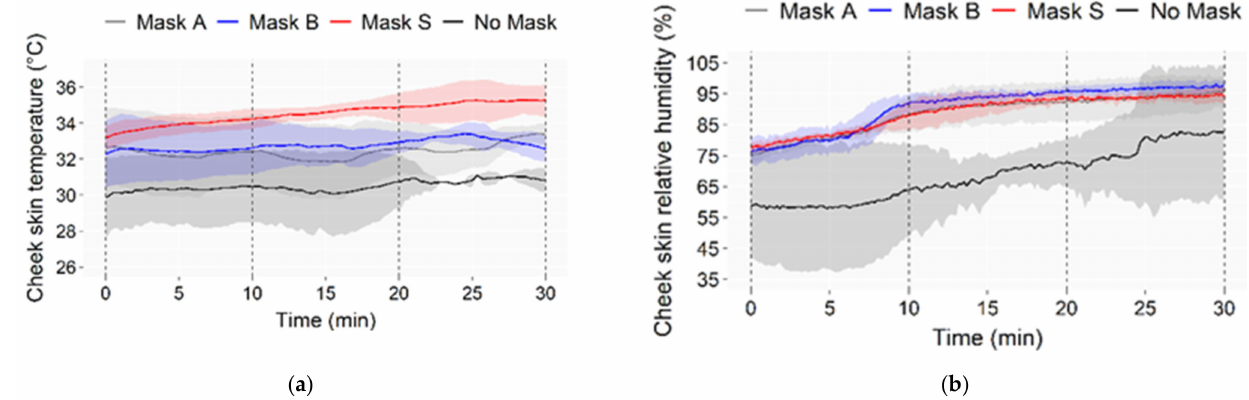
Figure 9. Cheek skin temperature ( a ) and relative humidity ( b ) reported as averages across testers. Shadowed areas represent the standard deviations.